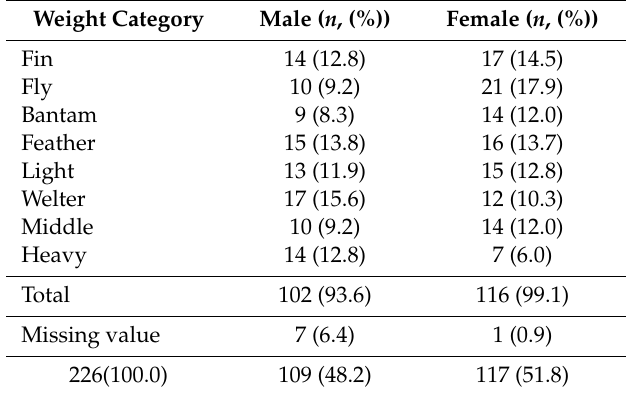
Table 2. The characteristics of respondents (male and female) by the continent according to the weight category.